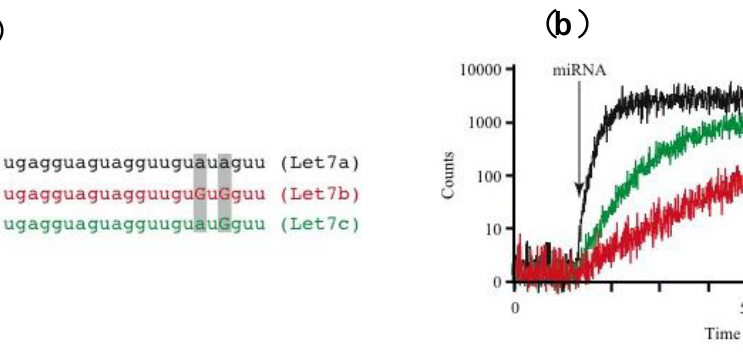
Figure 3. Identification of miRNAs having one or two mismatches with our TIRF-based microarray platform ( a ) mature sequences from Let7a1 (black), Let7b (red) and Let7c (green). Gray rectangles show the nucleotide mismatches found between Let7a1 (used as reference) and Let7b and Let7c; and ( b ) Mean values obtained from the readings of 10 spots (10 independent avalanche photodiodes) for each miRNA tested. The vertical arrow points to the time in which the synthetic miRNA was added to the system (either Let7a1, Let7b or Let7c). All miRNAs were added at a final concentration of 1 nM. Colors of the curves correspond to the sequences in (a). The MB printed on the microarray spots corresponds to the complementary sequence of Let7a1 (perfect matching). ( a ) ( b